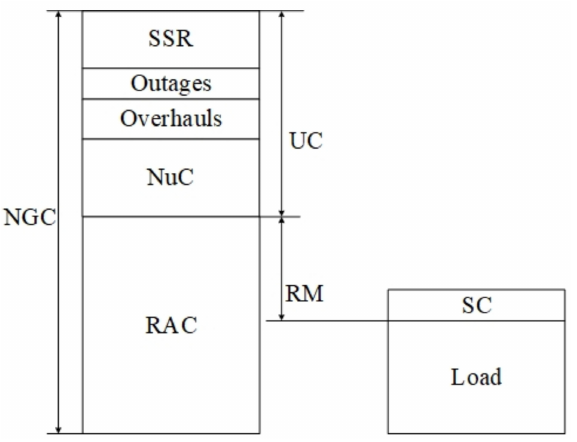
Figure 1. ENTSO-E deterministic indicators for adequacy (reliability)